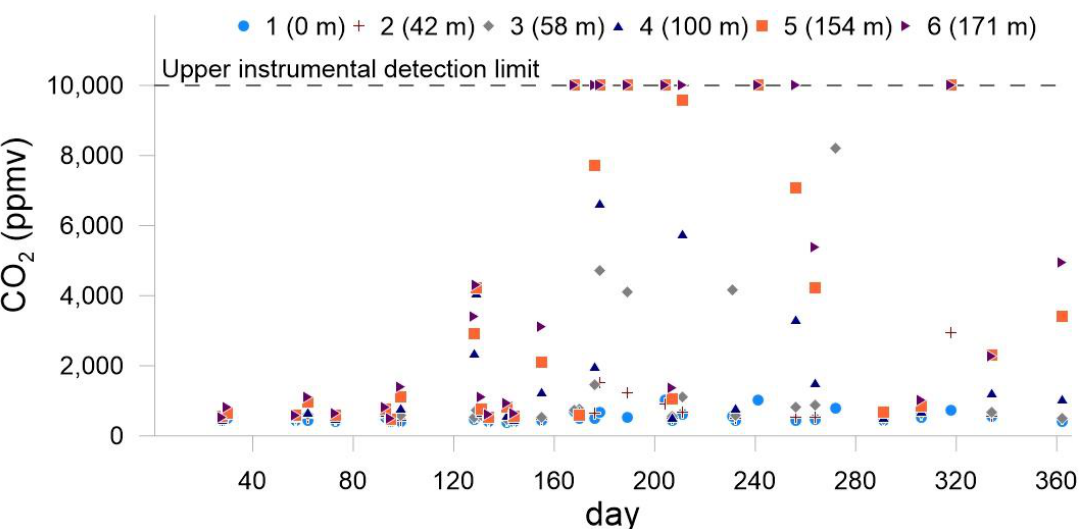
Figure 6. Spot air CO 2 concentrations data, measured inside Carburangeli cave at 60 cm from the cave floor, in the period 2000 – 2007; data related to the 2000 experiment refer to measures collected at 80 cm height. Time is expressed as the ordinal of the day of the year of acquisition of each measure. Progressive distances of the points from cave entrance are reported between round brackets (see also Figure 2 for point locations).